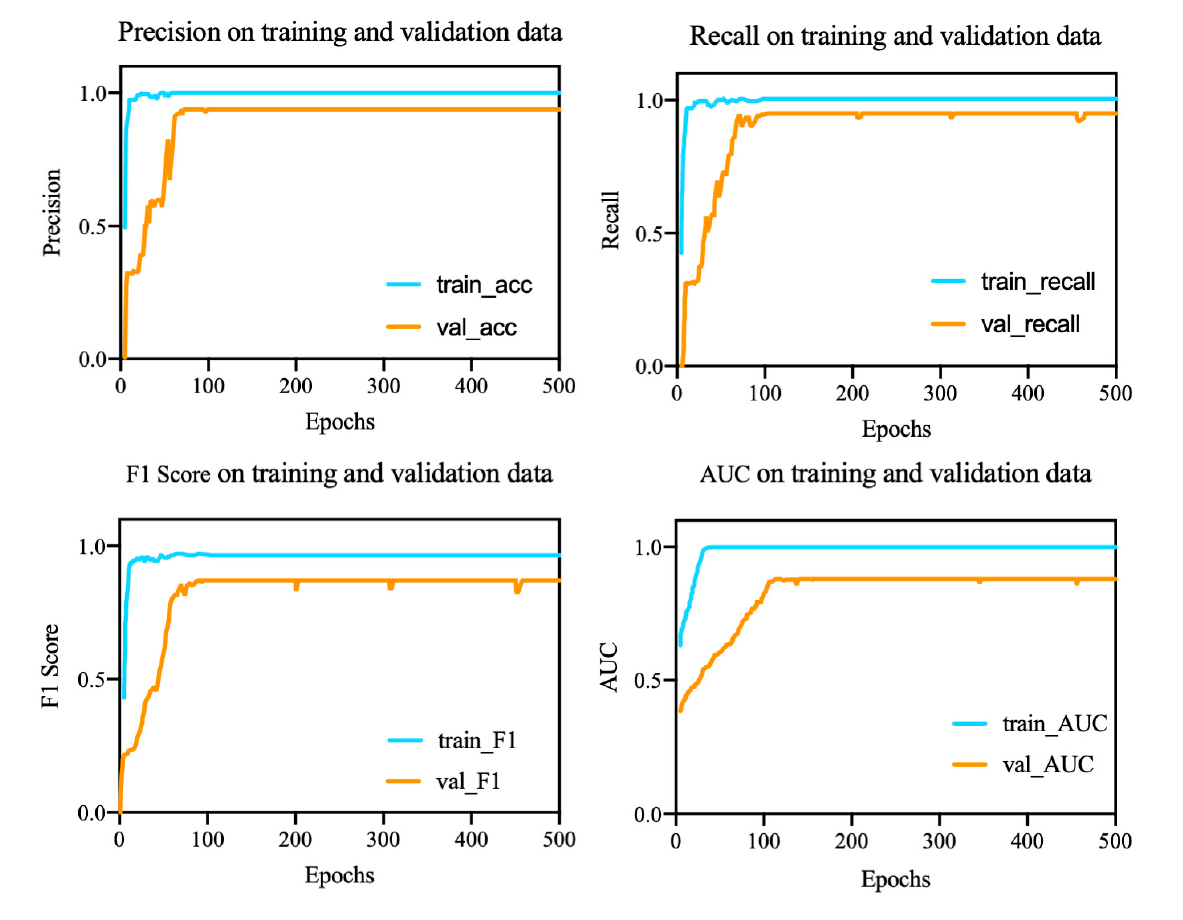
Figure 12. Model performance evaluation.